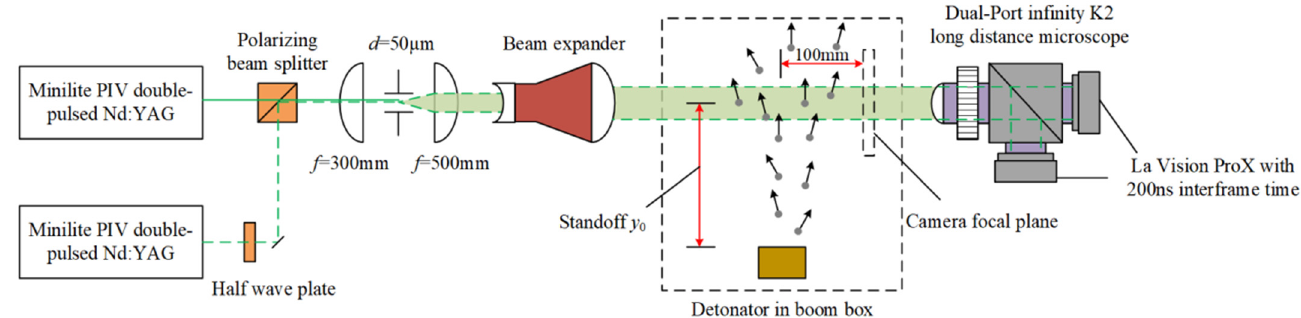
Figure 22. Digital in-line holography experimental configuration.